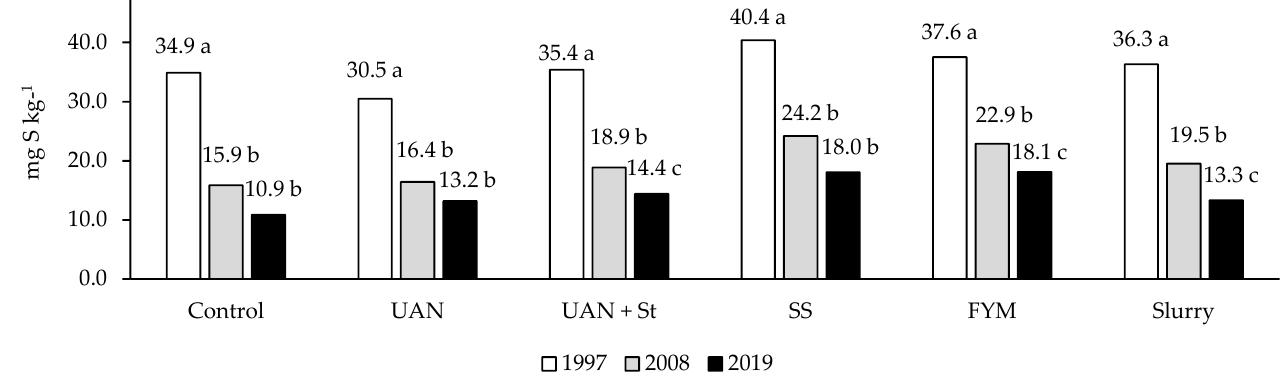
Figure 5. Content of available sulfur fraction (S av ) in topsoil. Different letters describe significant differences between years within the treatment. Tukey HSD test ( p < 0.05), ( n = 4).